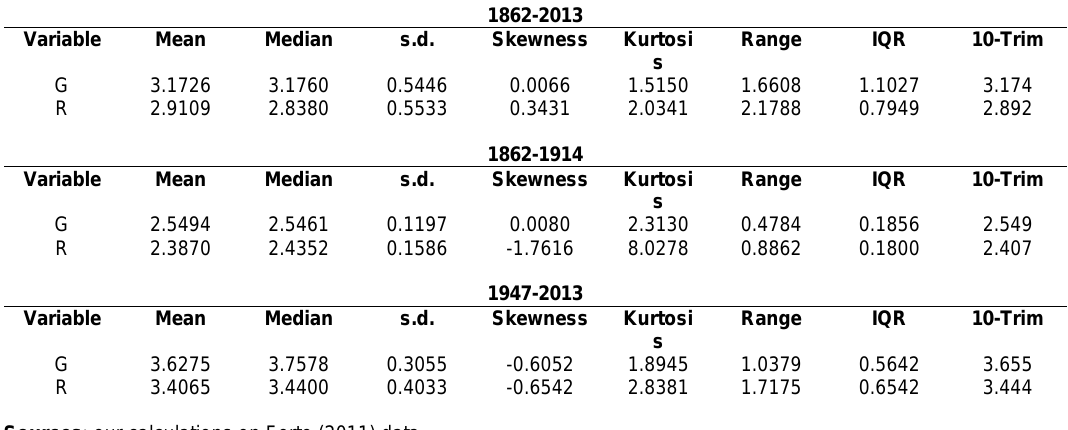
Table 1 . Exploratory data